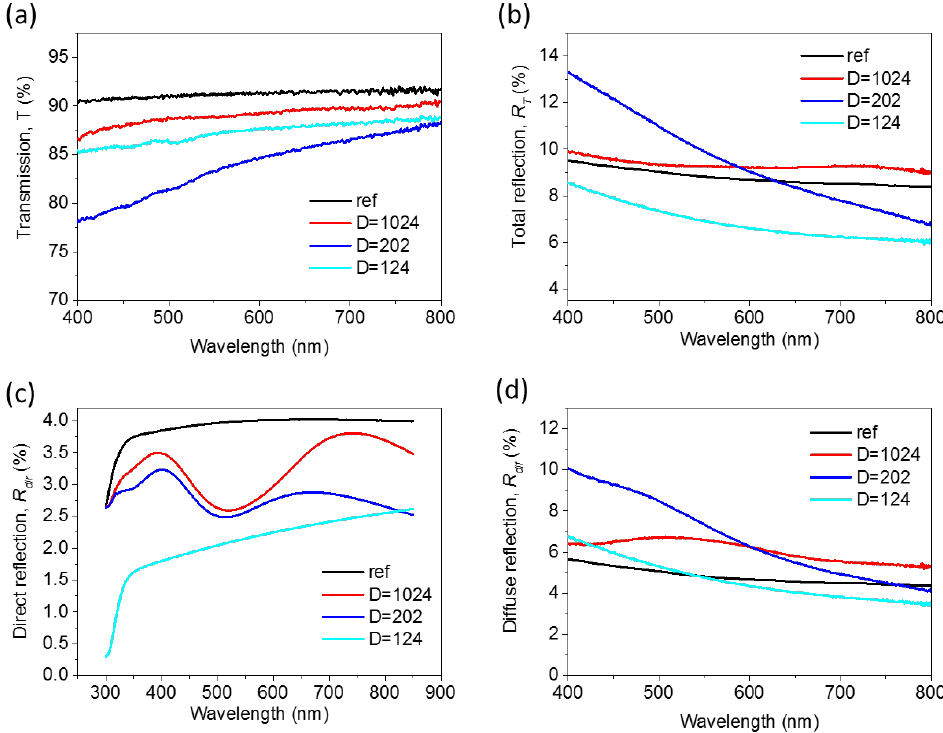
Figure 5. Optical measurements of disordered 2D nanostructures. ( a ) Transmission spectra (T). ( b ) Total reflection spectra (RT). ( c ) Direct reflection ( R dir ). ( d ) Diffuse reflection ( R dif ).